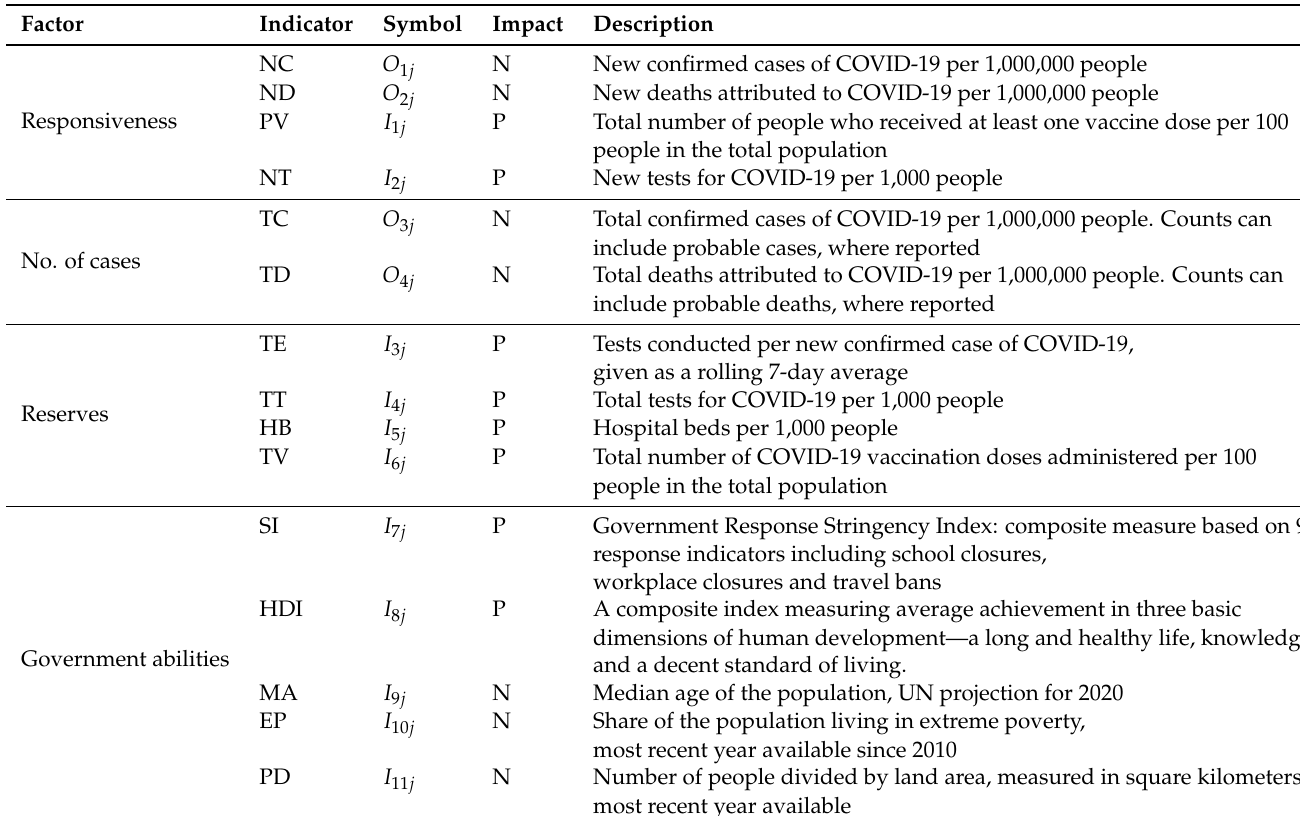
Table A1. Indicators for public health system against